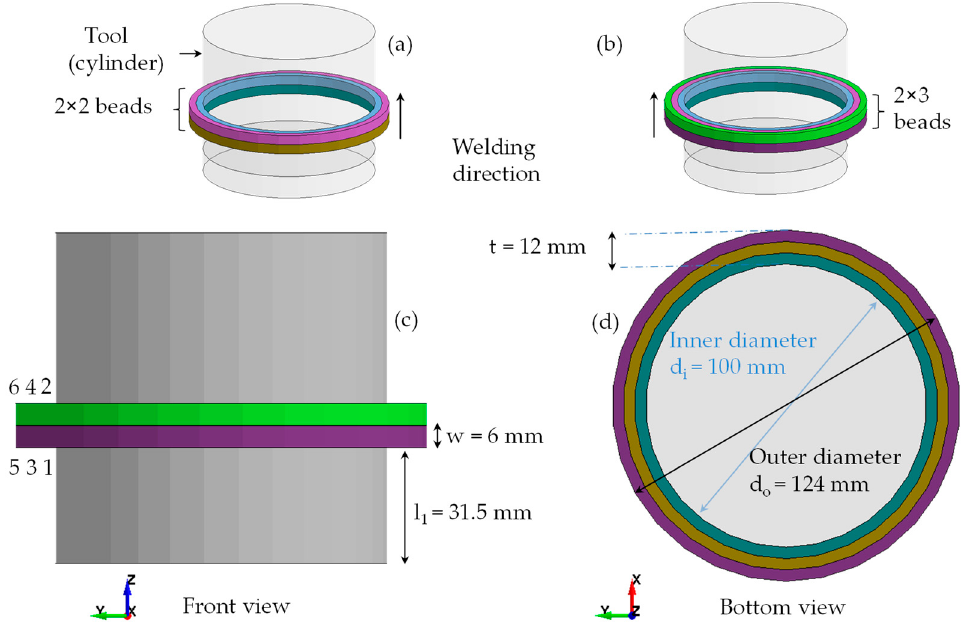
Figure 9. Pattern of the two beads in two layers (2 × 2) ( a ) and two beads in three layers (2 × 3) ( b , c ) on the tool with the A3 beads ( d ).